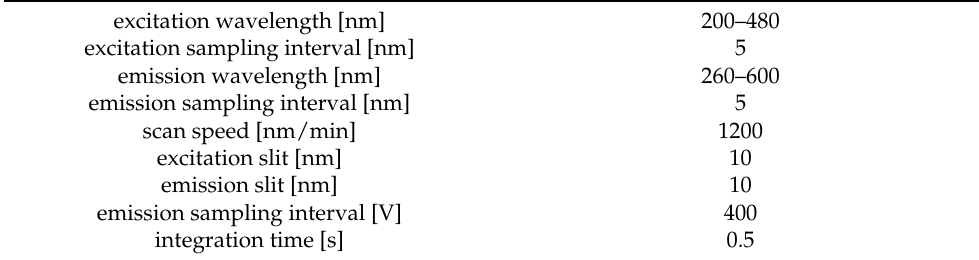
Table 2. Measurement parameters used for the Hitachi F-7000 FL spectrofluorometer.